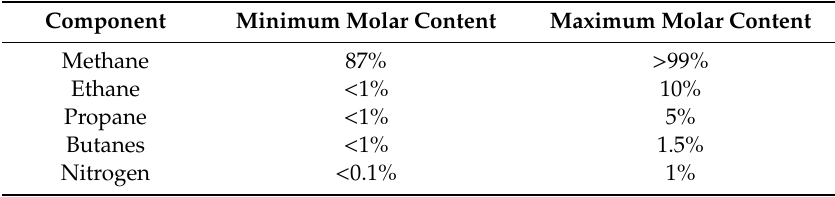
Table 1. Typical content limits of liquefied natural gas